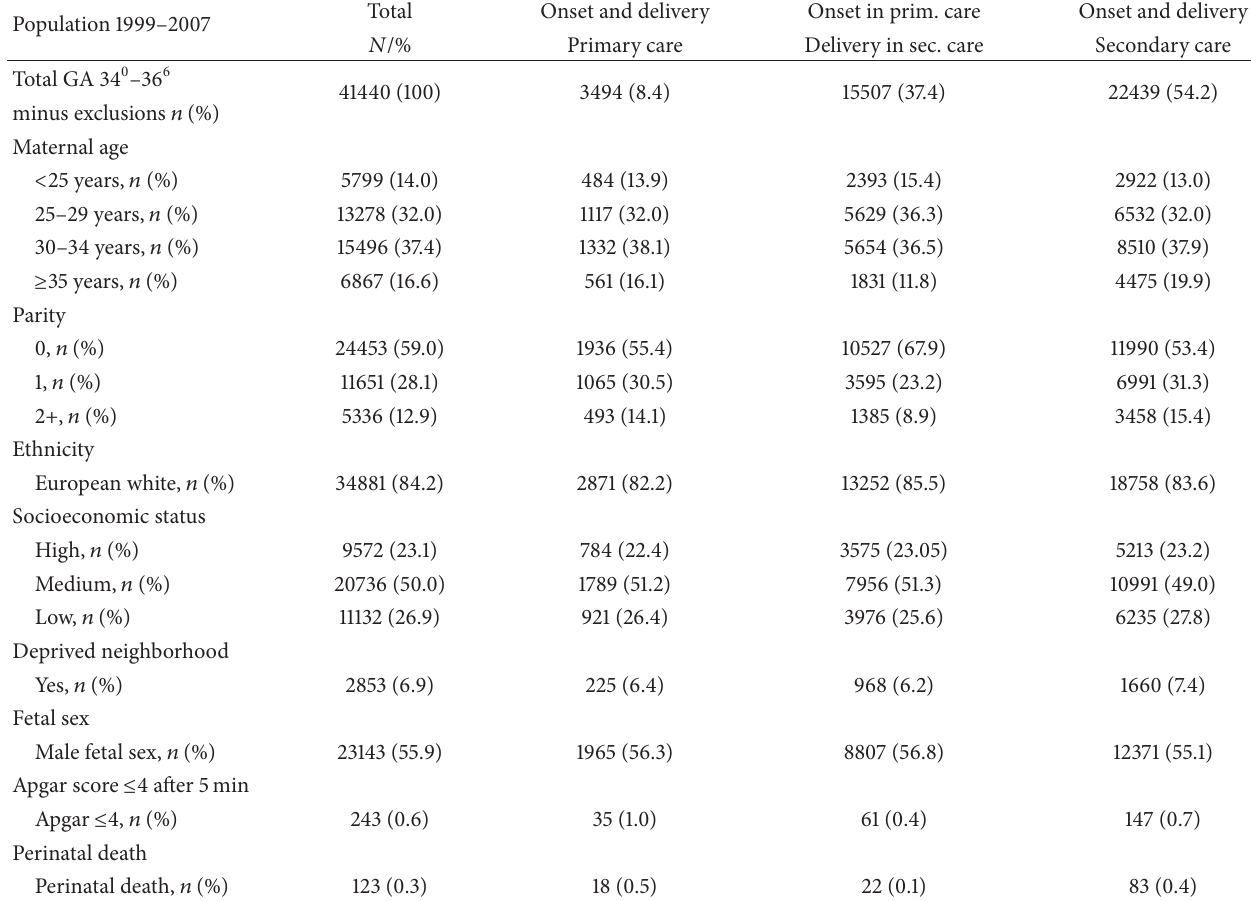
Table 4: Baseline characteristics and outcome of 41,440 women with late preterm delivery (GA 34 +0 –36 +6